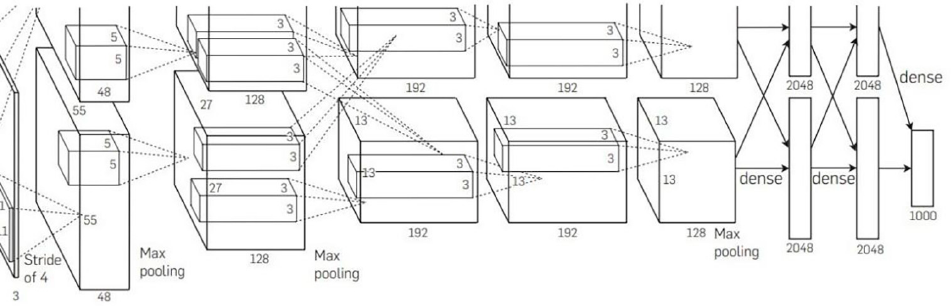
Figure 7. Structure of AlexNet network [10]. (Reprinted/adapted with permission from Ref. [ImageNet classification with deep convolutional neural networks]. A. Krizhevsky, Ilya Sutskever, Geoffrey E. Hinton·Published 3 December 2012·Computer Science·Communications of the ACM).